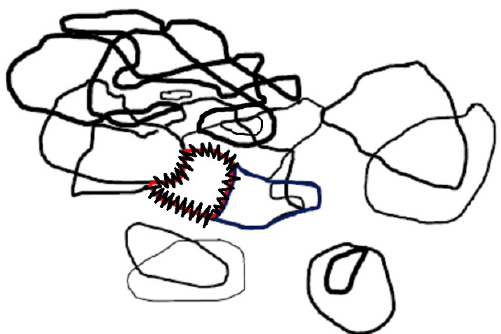
Figure 9 . Imagine that we move around the blue double arrow in all possible positions connecting one point on the \zigzagged" loop and one point on the \thin" loop. It then runs through a two- dimensional manifold of pairs of end-points , and to each such pair of end-points (of the double R(cid:22) arrow) the associated _ X -pair speci(cid:12)es a twodimensional plane spanned by the pair of _ X set(manifold) of all these planes makes up the set of tangent planes to the time-track (imbedded in the 25+1 dimensional physical Minkowsky space-time) for the closed string development in